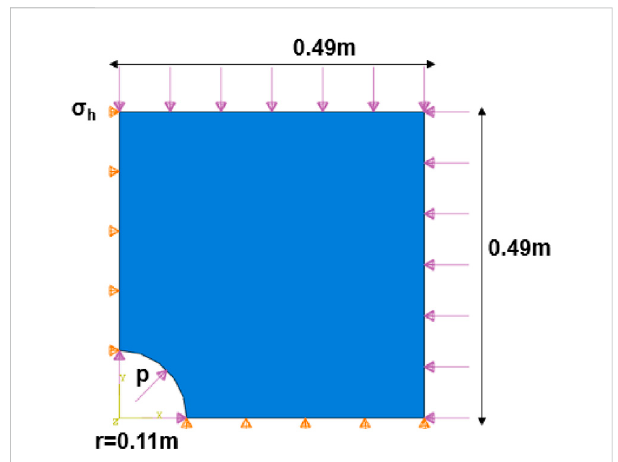
FIGURE 5 Near-wellbore mechanical